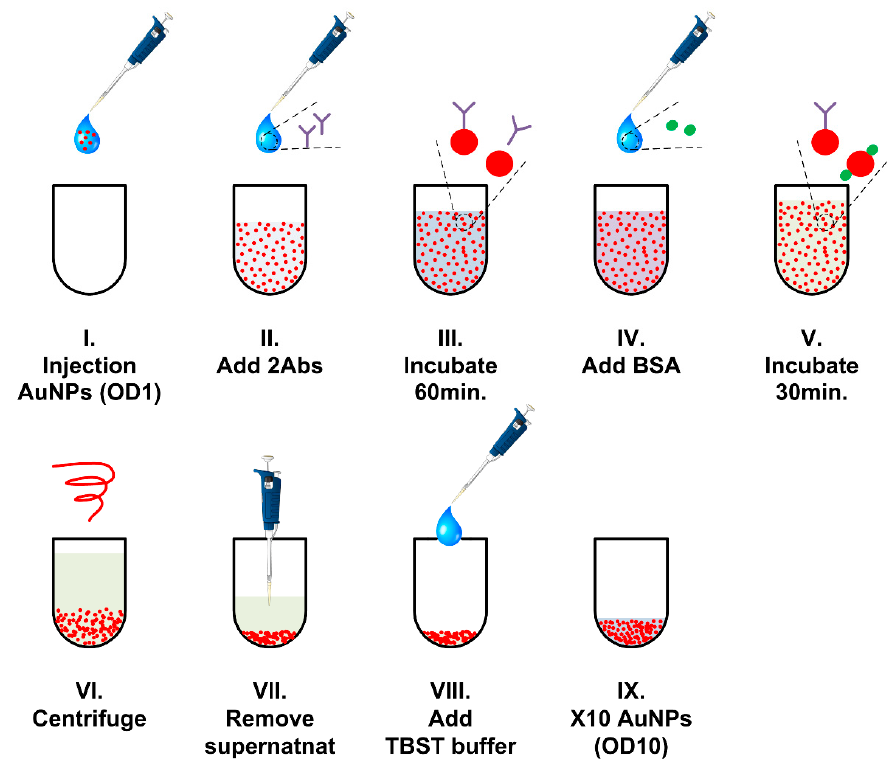
Figure 4. Process of conjugating secondary antibodies and gold nanoparticles.